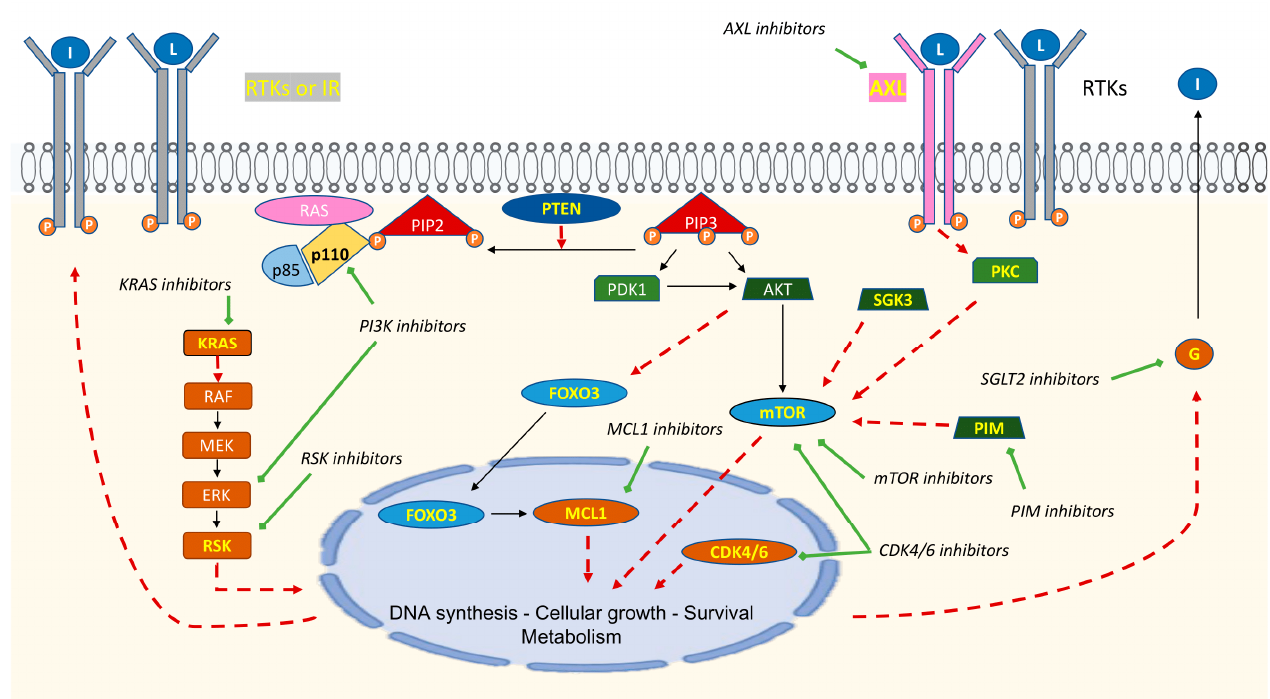
Figure 2. Summary diagram of main mechanisms of resistance to PI3K inhibitors and potential in- hibitors to counteract.